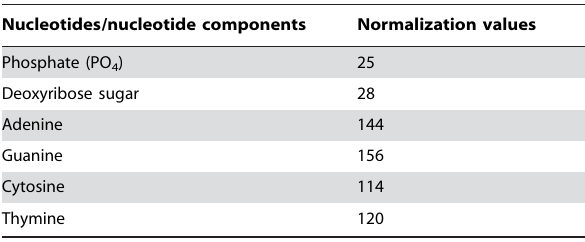
Table 5. Normalization values for the